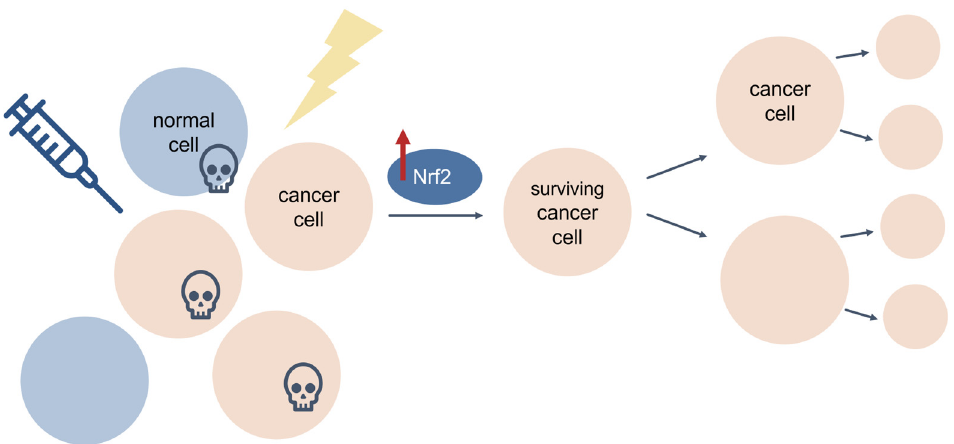
Figure 9. Nrf2 protects cancer cells from cancer therapy. Cancer cells hijack the Nrf2 pathway to confer protection against cancer therapies such as chemotherapy and radiation. Cancer cells that survive therapy develop resistance and proliferate, leading to chemoresistance and cancer progres- sion.